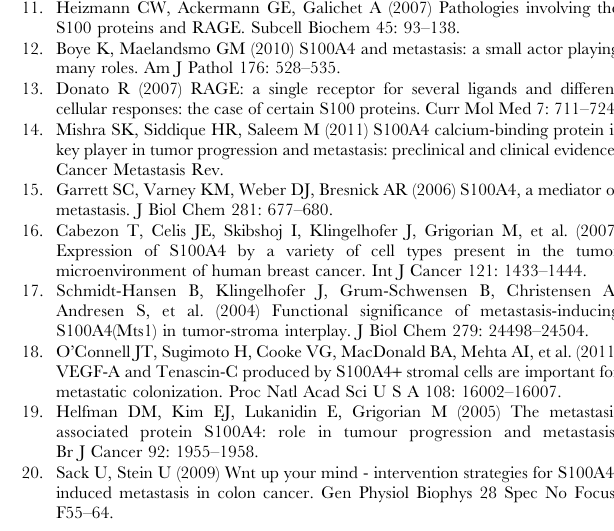
Figure S2 S100A4 determination in plasma samples. Plasma levels of S100A4 protein in several xenograft models in athymic mice compared with S100A4 levels in animals without tumor (no tumor) were determined by a sandwich ELISA method. One human pancreatic adenocarcinoma cell line (MiaPACA-2), two human colon adenocarcinoma cell lines (HCT116 and Colo205) and one human breast adenocarcinoma cell line (MDAMB231) were used for tumor growth. Plasma levels were measured at the end of the experiment. Graph of plasma levels shows the mean 6 SEM ( n = 10). **p , 0.01, ***p , 0.001. (TIF) Figure S3 Cytotoxic effect of Gemcitabine combined with 5C3 mAb in MiaPACA-2 cells. The effect of Gemcita- bine, alone or in combination with 5C3 mAb, on cell viability was measured by hexosaminidase activity and BrdU incorporation. A) Dose-response effect of Gemcitabine was improved synergistically with the combination of 5C3 mAb. MiaPACA-2 cells were incubated with the chemotherapeutic drug at different doses (from 5 m M to 2 nM, dil 1:3) with or without 5C3, at a constant concentration of 40 nM or 100 nM, for 72 h. Percentage of viability was determined in comparison to the positive control (cells without compounds) that represents 100% viability. B) Effect on proliferation for the combination of different doses of Gemcitabine (from 5 m M to 2 nM, dil 1:3) with 5C3 at 40 nM of 100 nM, along 72 h. The level of interaction (synergistic, additive or antagonist effect) between Gemcitabine and 5C3 was quantified by the combination index (CI): CI ~ D ð Þ 1 = Dm ð Þ 1 where (Dm)1 =EC50 Drug 1 concentration and (D)1= EC50 (Drug 1 + Drug 2). The error bars represent mean 6 SEM ( n = 6).